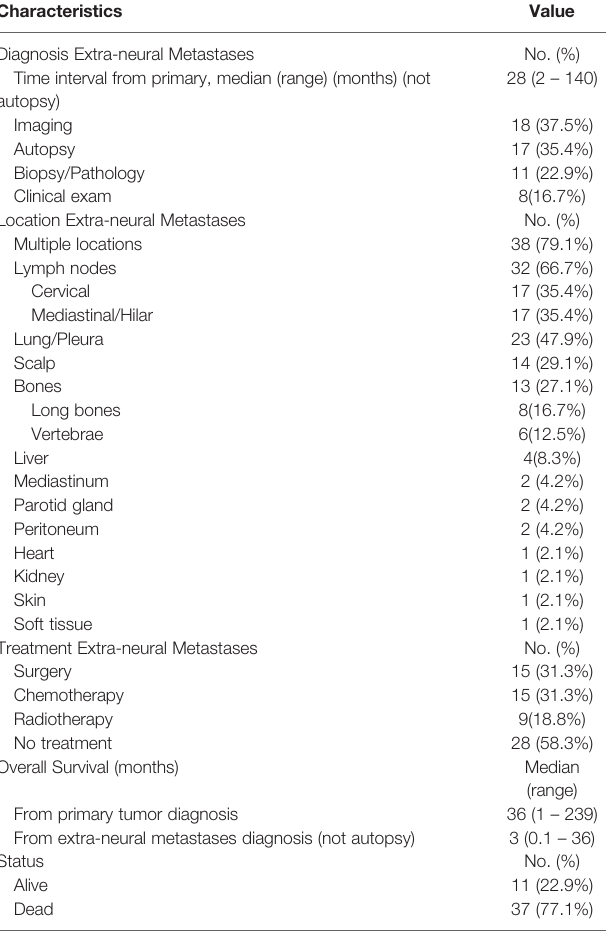
TABLE 3 | Summary of clinical characteristics, management strategies, and survival of all pooled extra-neural metastases.